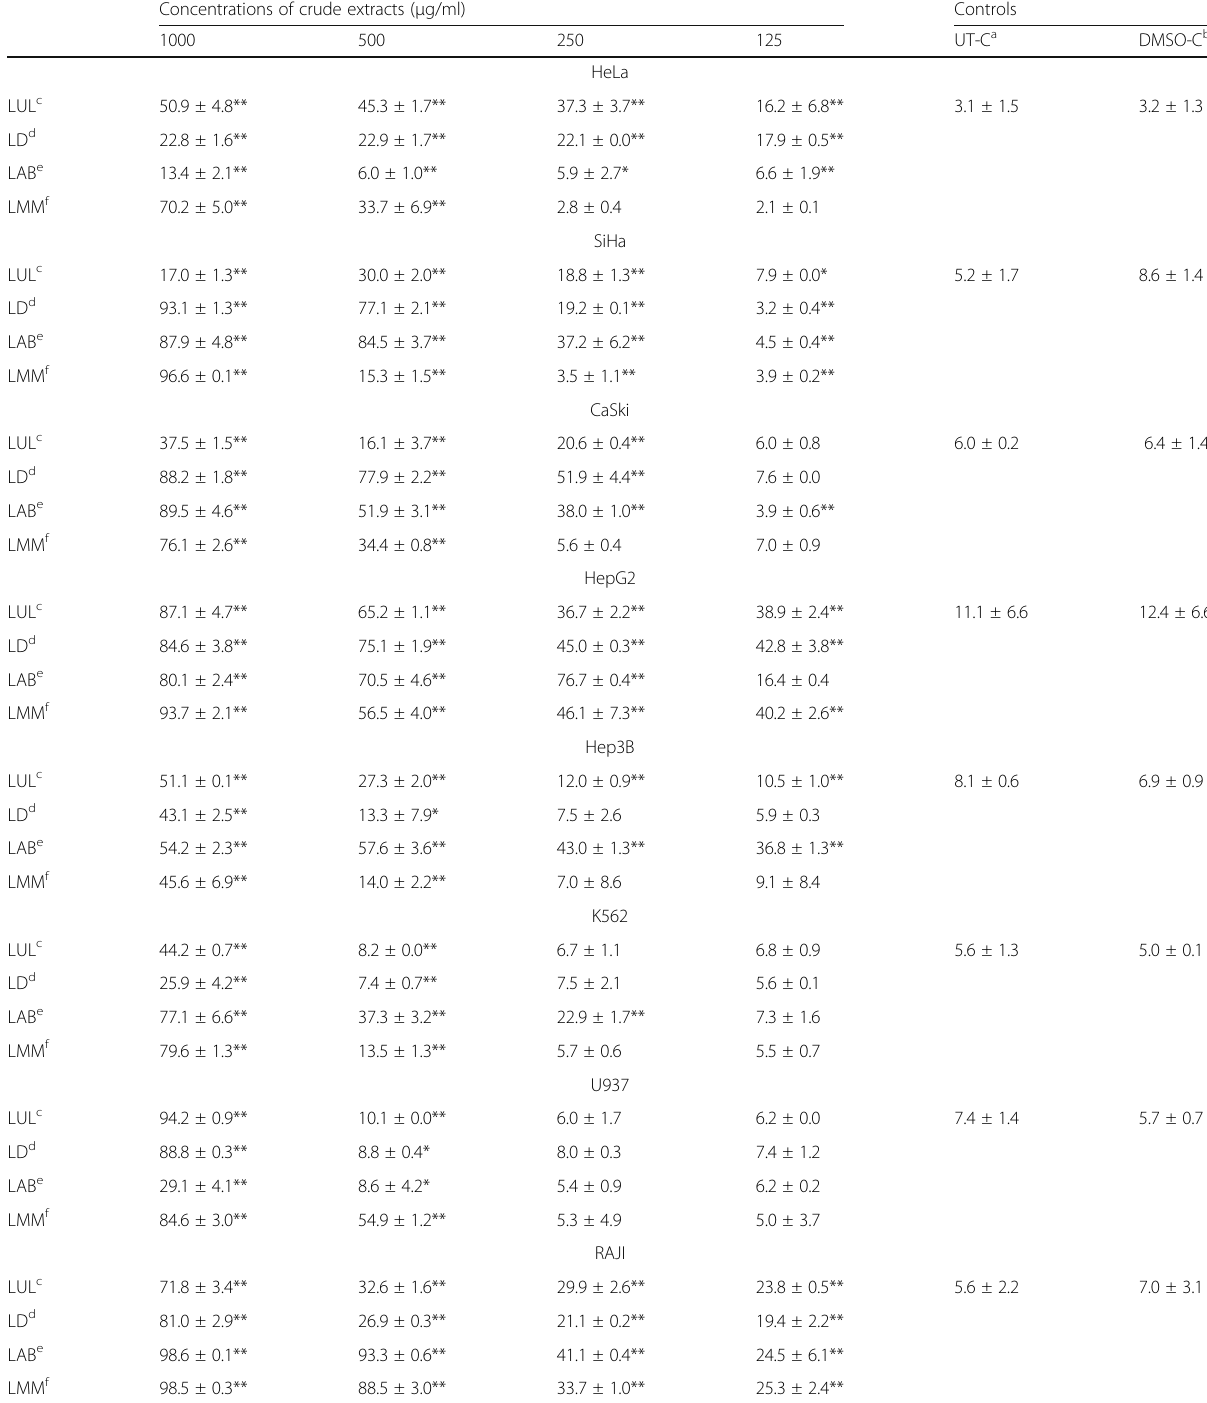
Table 1 The average (±SD) percentages of apoptotic cells identified from the dot plots of Annexin V vs PI with statistical analysis Concentrations of crude extracts ( μ